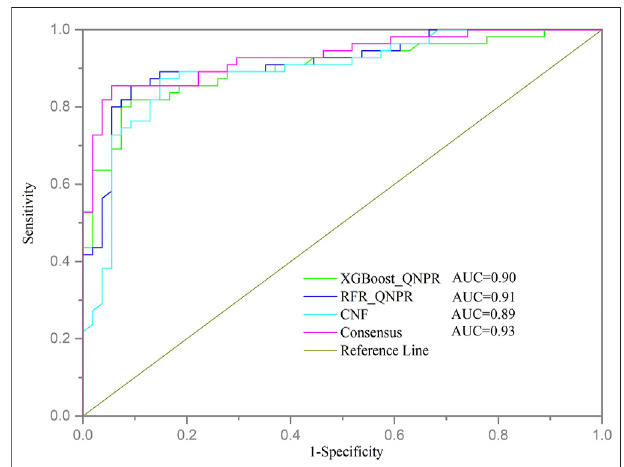
FIGURE 2 | ROC curve of models on external validation. Each color line represents a